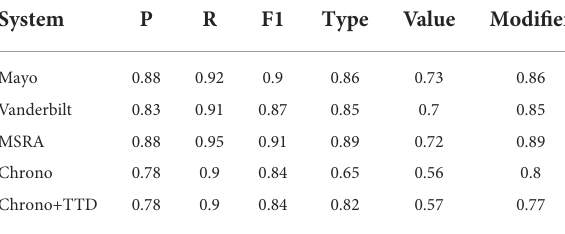
TABLE 7 End-2-End results for state-of-the-art systems, Chrono, and Chrono+TTD (ClinBioBert-Seq2Seq-Ttype), with FREQUENCY temporal phrases removed, using span-based P, R, and F1